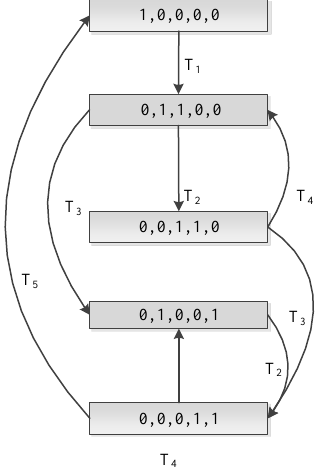
Figure 5. The reachable graph of the sample.